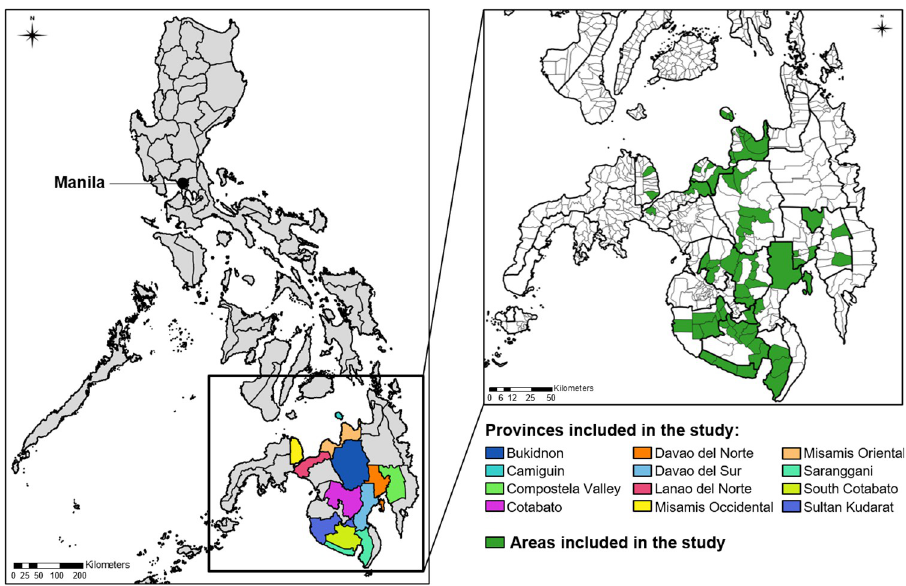
Fig 1. Map of the Philippines and the study regions. The Philippines is geographically divided into 87 provinces, with the capital city Manila located in the northern National Capital Region (NCR). Twelve southern provinces of the Mindanao geographic region where datasets were complete for the period 2013–2018 were included in our study, colour-coded on left. Inset, on right: the 65 areas within those provinces that were included in our study are indicated in green (comprising 14 cities and 51 municipalities). Provincial boundaries are marked by thick borders. Map data derived from the Humanitarian Data Exchange (https://data.humdata.org/)".